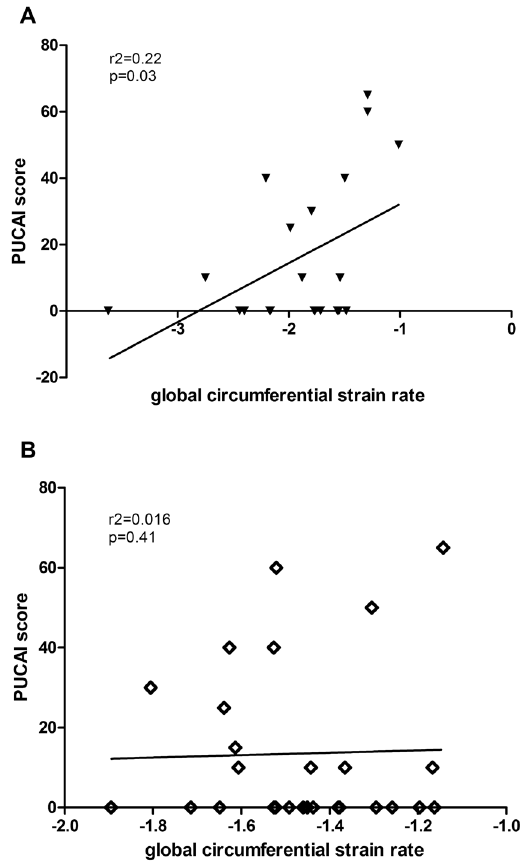
Figure 3. Correlation analysis between PUCAI and LV peak circumferential strain rate during exercise ( A ) and at rest in pediatric UC patients ( B